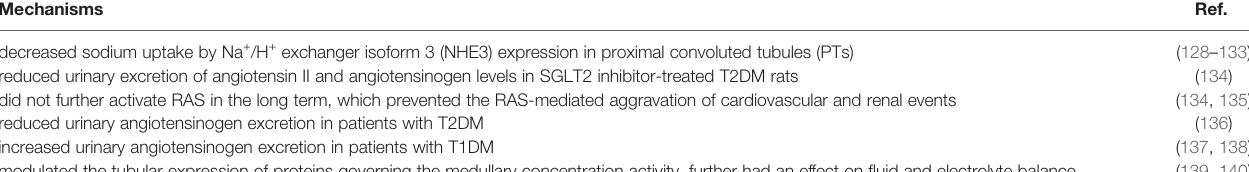
TABLE 2 | Proposed hypotheses for the kidney protective mechanisms of SGLT2 inhibitors in DKD.